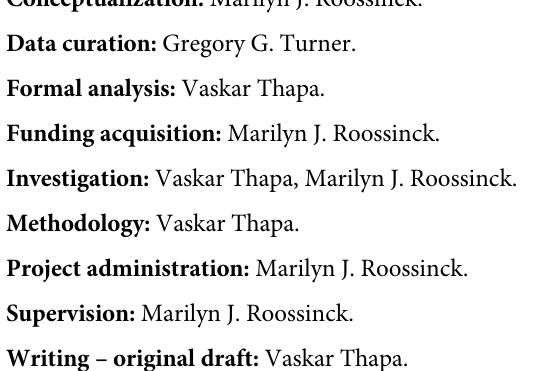
S6 Fig. The spread of white-nose syndrome in North America as predicted from Pseudo- gymnoascus destructans partitivirus-pa phylogeographic analysis in BEAST using a subset of 134 samples, visualized in Google Earth with SPREAD v1.0.7 and transferred manually to a USGS map. The lines connecting different locations represent branches in the maximum clade credibility tree. The bright to dark gradient of the line’s red color represent time from 1999 to 2018. Note higher number of connectivity in New York, West Virginia and Kentucky. (PPTX) S7 Fig. A snapshot of white-nose syndrome spread in 1999 inferred from Pseudogmnoas- cus destructans partitivirus-pa subset sample of 134 plotted in Google Earth using SPREAD v1.0.7 and transferred to a USFS map. The line between the locations represent branches in the maximum clade credibility (MCC) tree. The dark to light color gradient of the circles indicate the relative age of the branch inferred (old to recent).